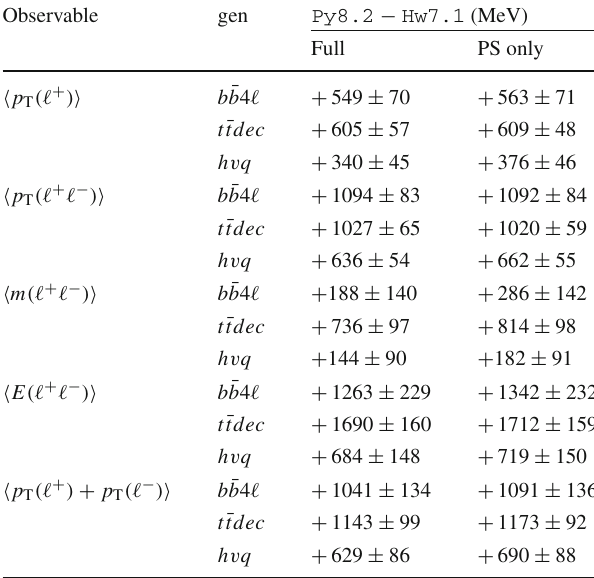
Table 24 Differences between the Pythia8.2 and Herwig7.1 results for the leptonic observables, at full hadron level and at parton- level only Observable gen